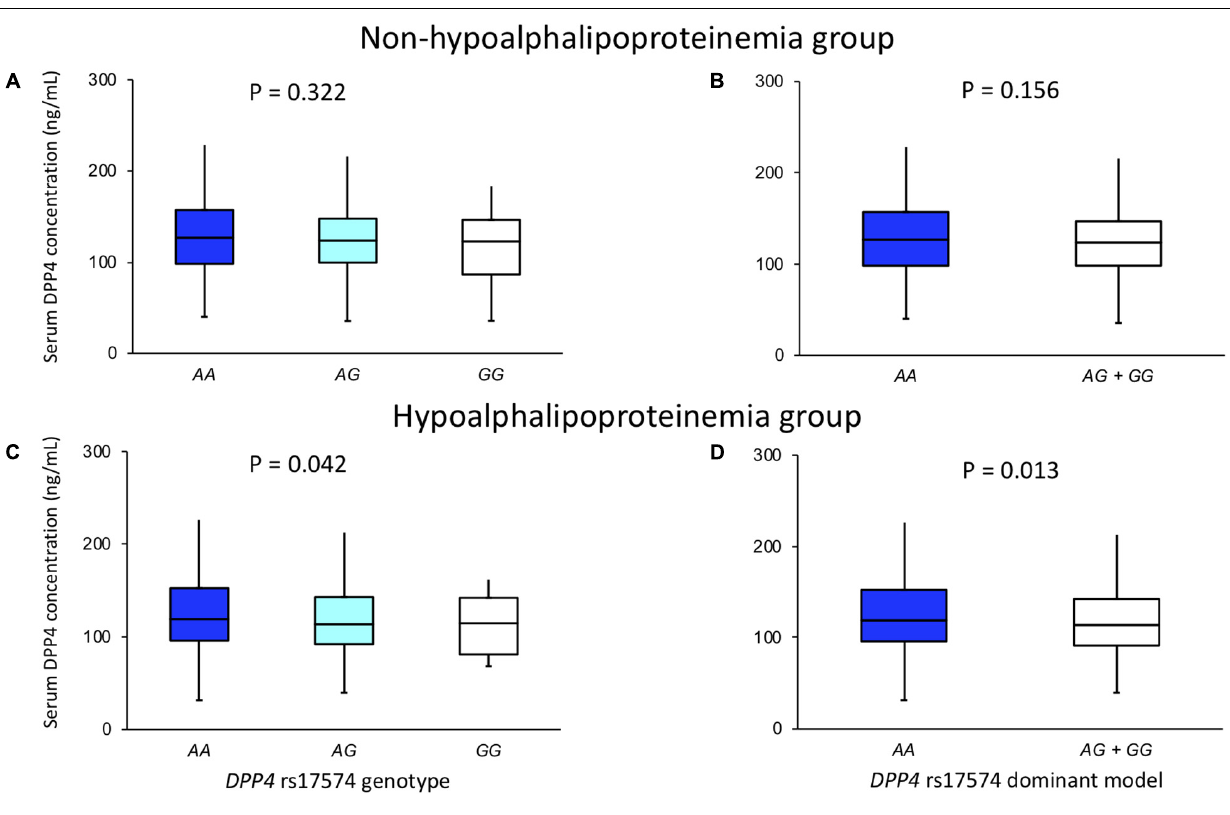
FIGURE 3 | DPP4 concentration in non-hypoalphalipoproteinemia (A,B) and hypoalphalipoproteinemia (C,D) groups, stratified by rs17574 genotypes (A,C) and in non-carries ( AA ) and carriers ( AG + GG ) of rs17574 minor allele (B,D)